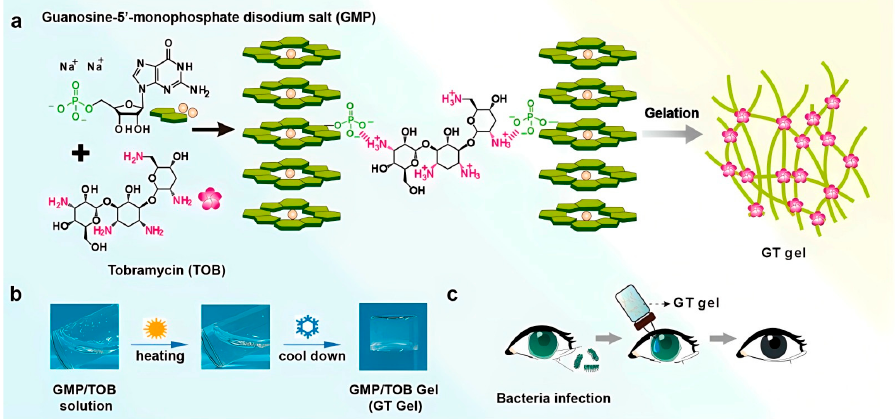
Figure 4. ( a ) Illustration of GMP-TOB Gel (GT Gel) formation via electrostatic interactions between GMP-based G-quadruplex and tobramycin. ( b ) GT Gel preparation scheme, the process involves heating and cooling. The final objective of the GT gel is the treatment of bacterial keratitis ( c ). Reprinted with permission from Ref. [74].